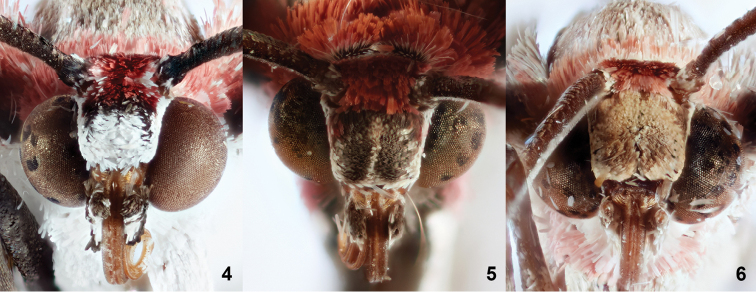
Frontal view of head for Stamnodes
fergusoni and related species. 4Stamnodes
fergusoni; 5Stamnodes
fervefactaria; 6Stamnodes
deceptiva.